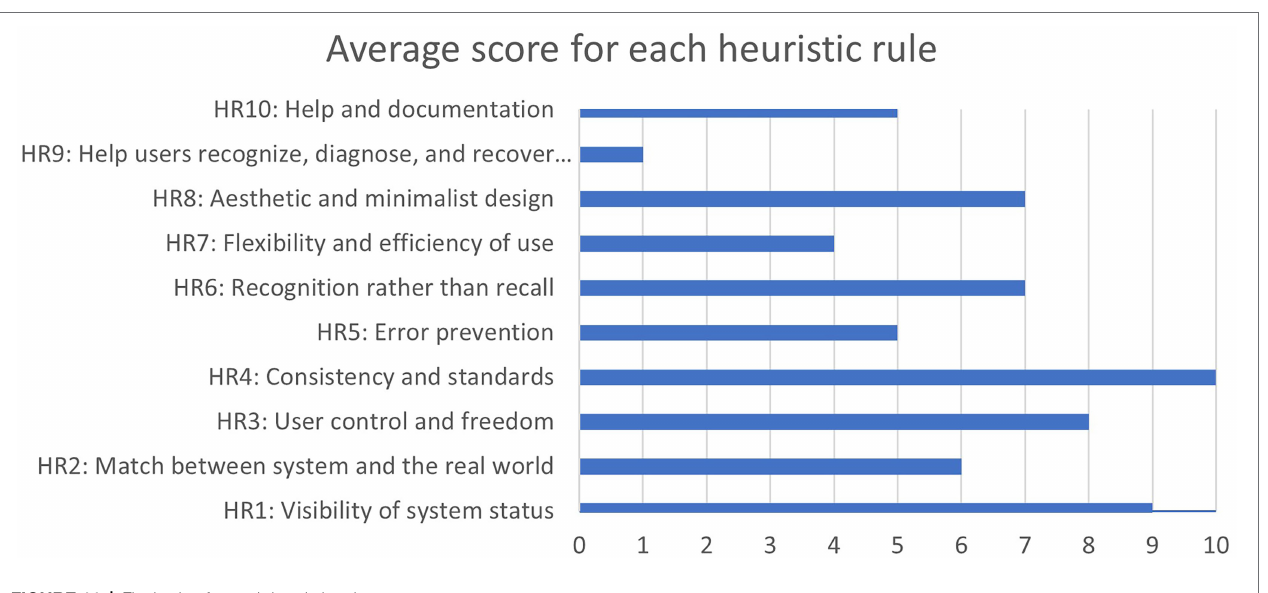
FIGURE 11 | Final value for each heuristic